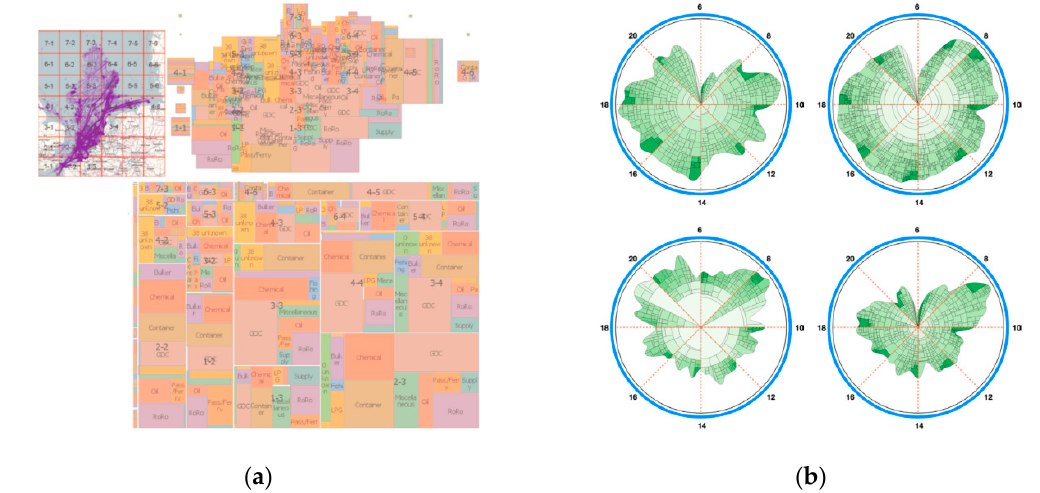
Figure 30. ( a ) Spatially ordered treemap visualization [40]; and ( b ) TelCoVis [82] visualization results